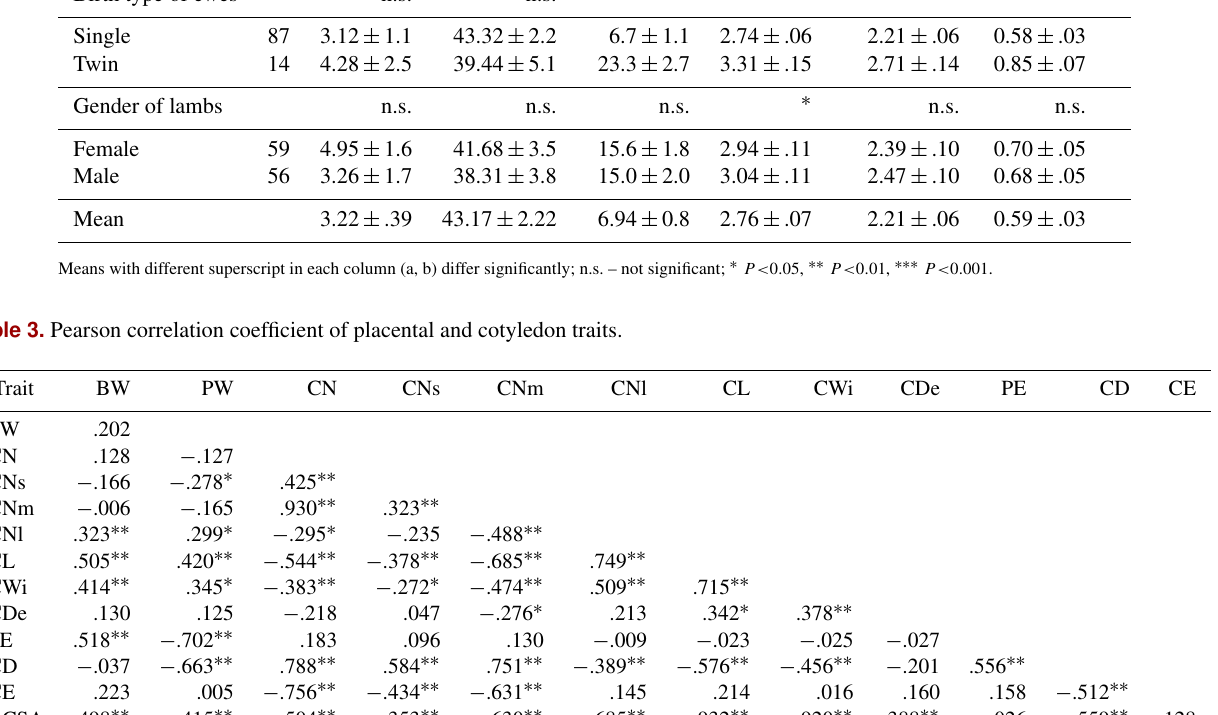
Table 2. Effect of parity, birth type and sex on cotyledon traits ( X ± SD). N CNs CNm CNl CL (mm) CWi (mm) CDe (mm) Parity n.s. n.s. n.s. n.s. n.s.